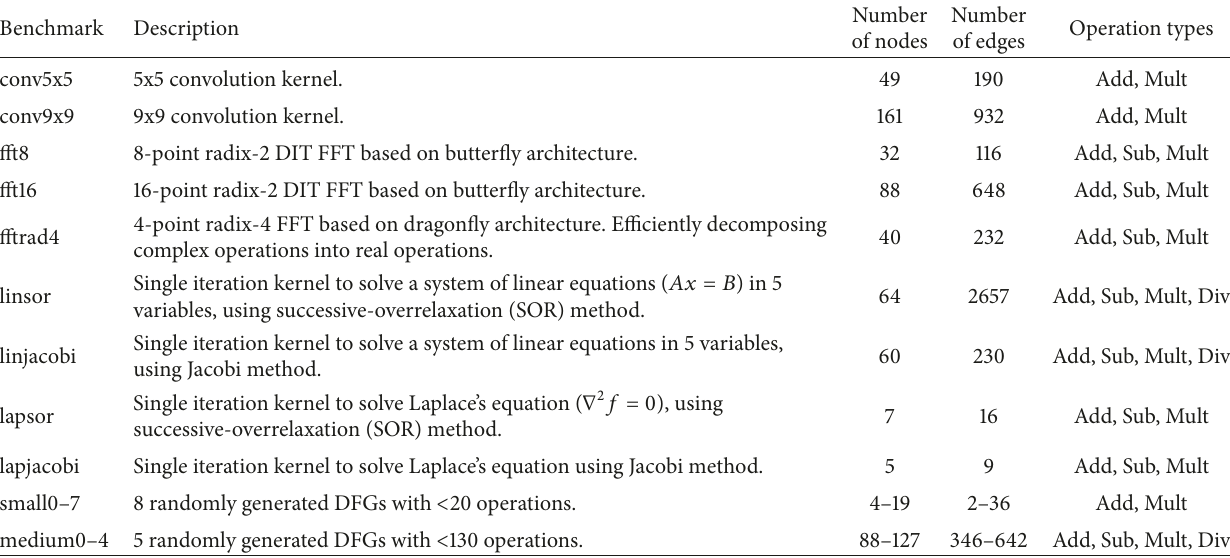
Table 1: Benchmark